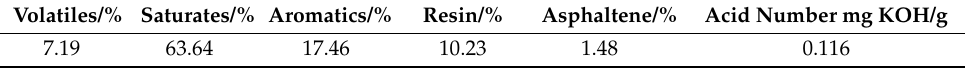
Table 2. Physical properties of crude